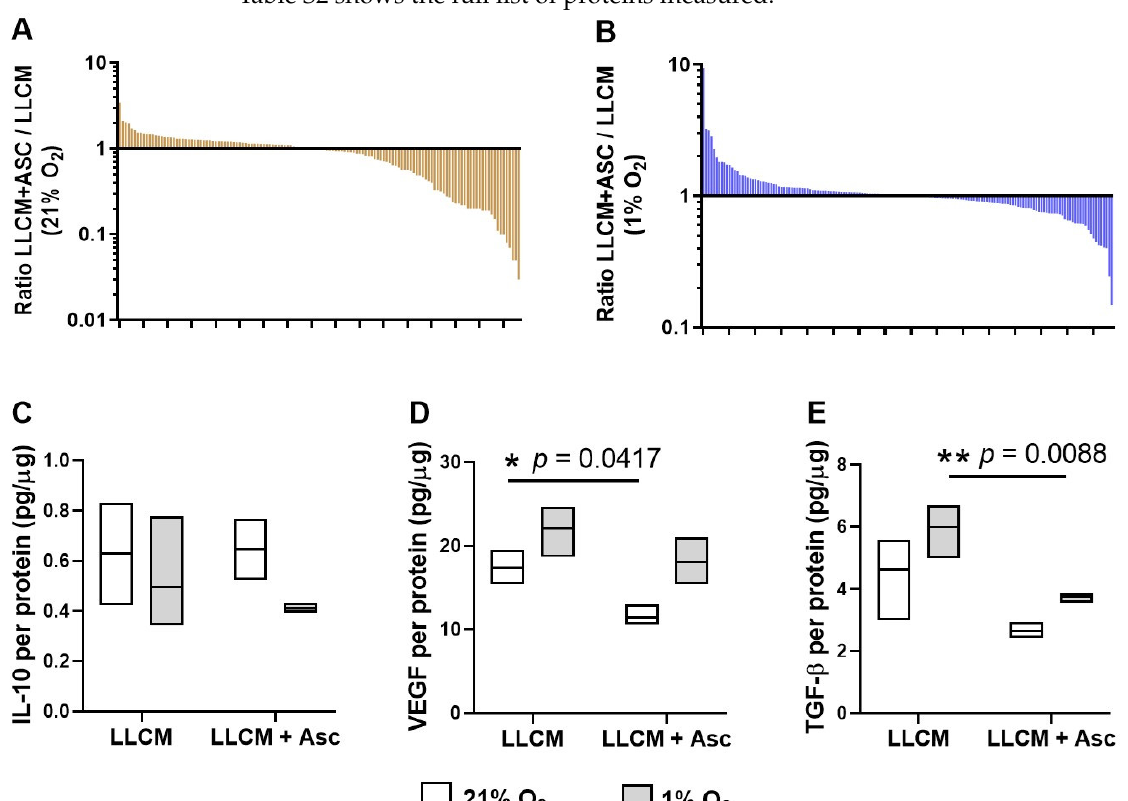
Figure 5. Effect of ascorbate on levels of protein analytes present in media of LLCM-grown bone marrow derived macrophages. Isolated bone marrow cells were grown with LLCM or LLCM + Asc for 7 days at ambient air (21% O 2 ) or subjected to hypoxia on day 6 for ~18 h (1% O 2 ). Media was refreshed on day 6 prior to harvest on day 7. Media from 3 independent experiments (3 mice) were pooled for a chemiluminescent protein array of 308 analytes. Graphs represent waterfall plots of the ratio of LLCM + Asc vs. LLCM of individual protein analytes present in media conditioned by BMDMs cultured at ( A ) 21% O 2 and ( B ) 1% O 2 , respectively. At 21% O 2 , most of the observed change were ascorbate-mediated reduction in protein levels, while at 1% O 2 , there was a more balanced change in both directions. Selected secreted proteins were measured by ELISA, showing data for IL-10 ( C ), TGF- β ( D ) and VEGF-A ( E ). Box plots represent data from 3 independent experiments (median ± min/max). Paired t -tests were performed, * p < 0.05, ** p <